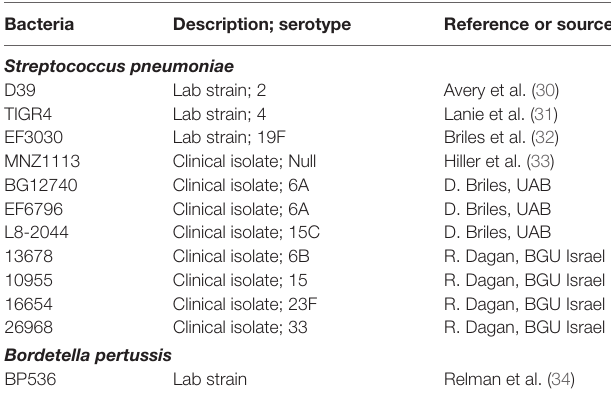
Table 1 | Bacteria used in study.